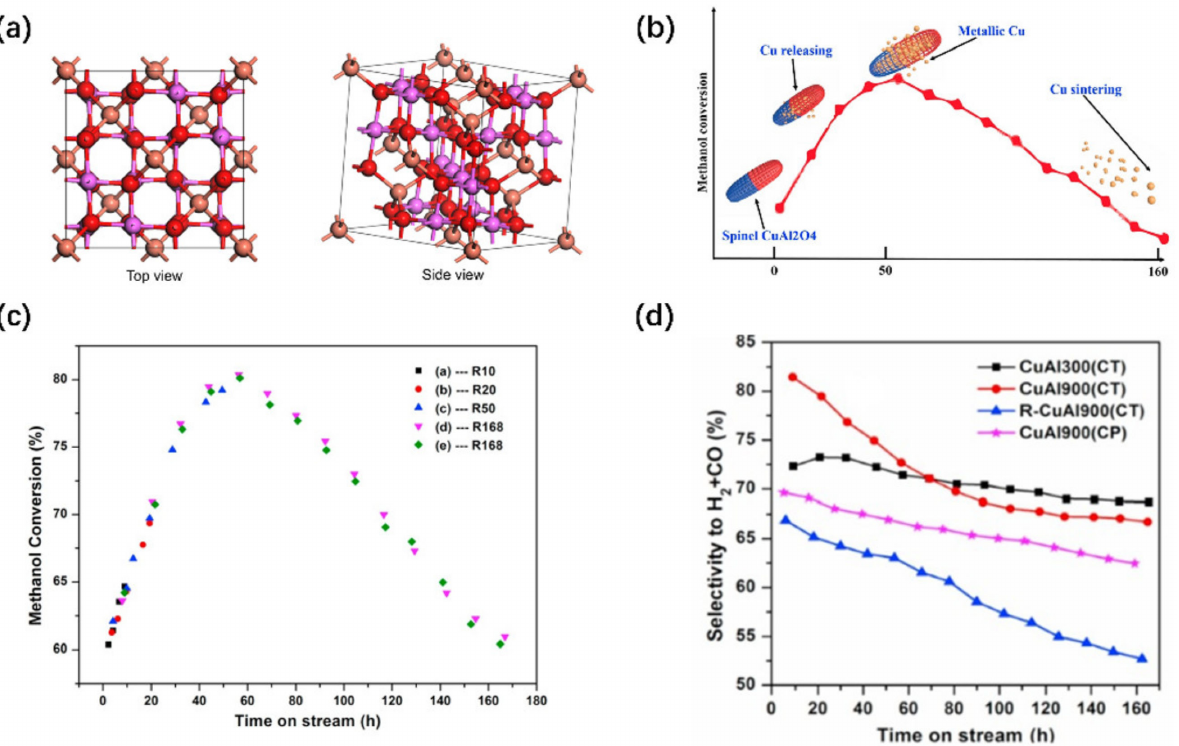
Figure 7. Cu-Al spinel catalyst for hydrogen production from methanol: ( a ) CuAlO 2 cell; ( b ) variation of CuAl 2 O 4 catalytic activity with time; ( c ) catalytic activity of samples prepared at 900 ◦ C as a function of time; and ( d ) variation of catalytic performance of different Cu-Al oxide catalysts with time. Reproduced with permission [43]. Copyright Elsevier,